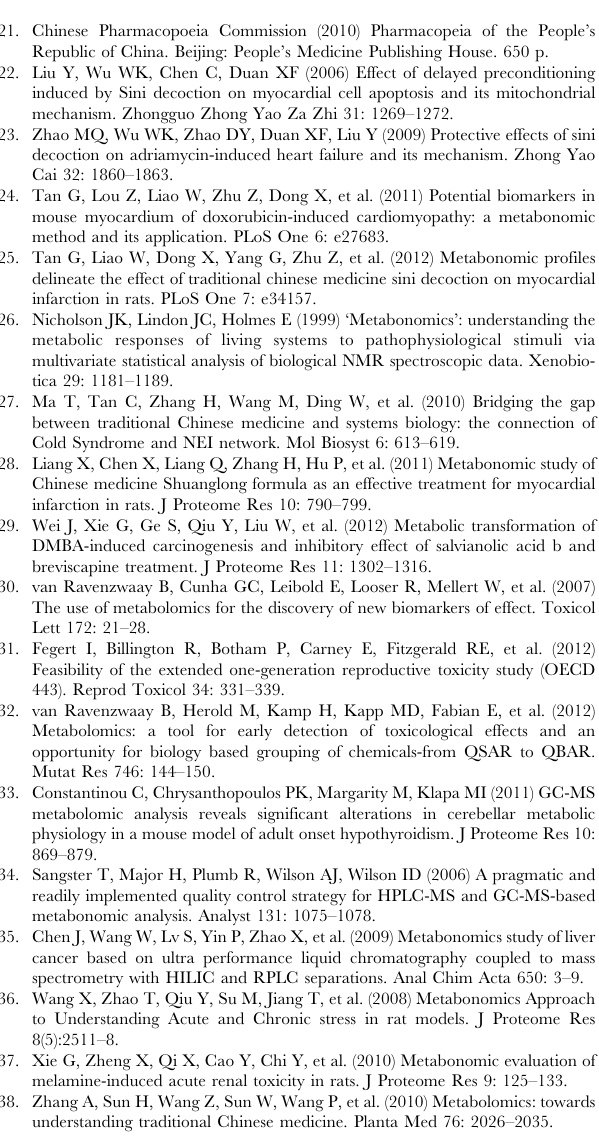
Figure S1 Comparison of biomarkers and related pathways between MMI- and PTU-induced hypothyroid- ism models.